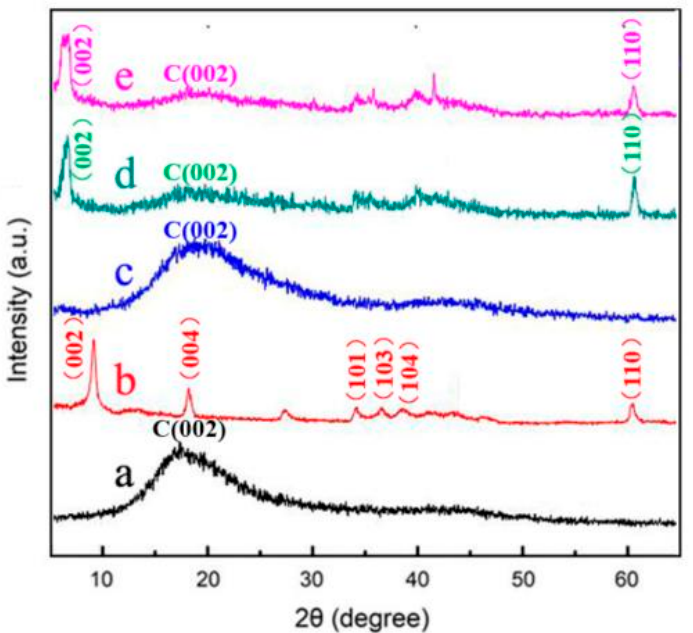
Figure 6. XRD patterns of epoxy ( a ), Ti 3 C 2 T x MXene nanosheets ( b ), EP / Ti 3 C 2 T x MXene nanosheets composite containing 0.4 wt % Ti 3 C 2 T x ( c ), EP / Ti 3 C 2 T x MXene nanosheets composite containing 1.0 wt % Ti 3 C 2 T x ( d ), and EP / Ti 3 C 2 T x MXene nanosheets composite containing 1.6 wt % Ti 3 C 2 T x ( e ).